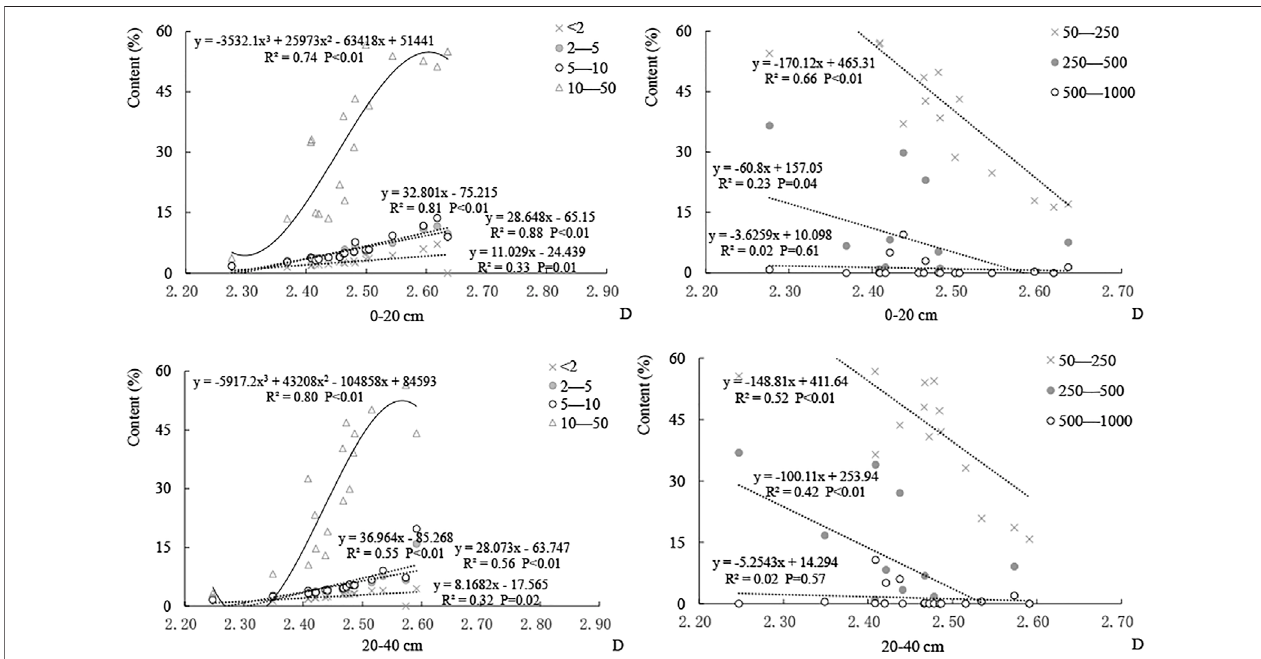
FIGURE 6 | Content relationship between D and the particle size in the woodland (W) in the fl ooded area.